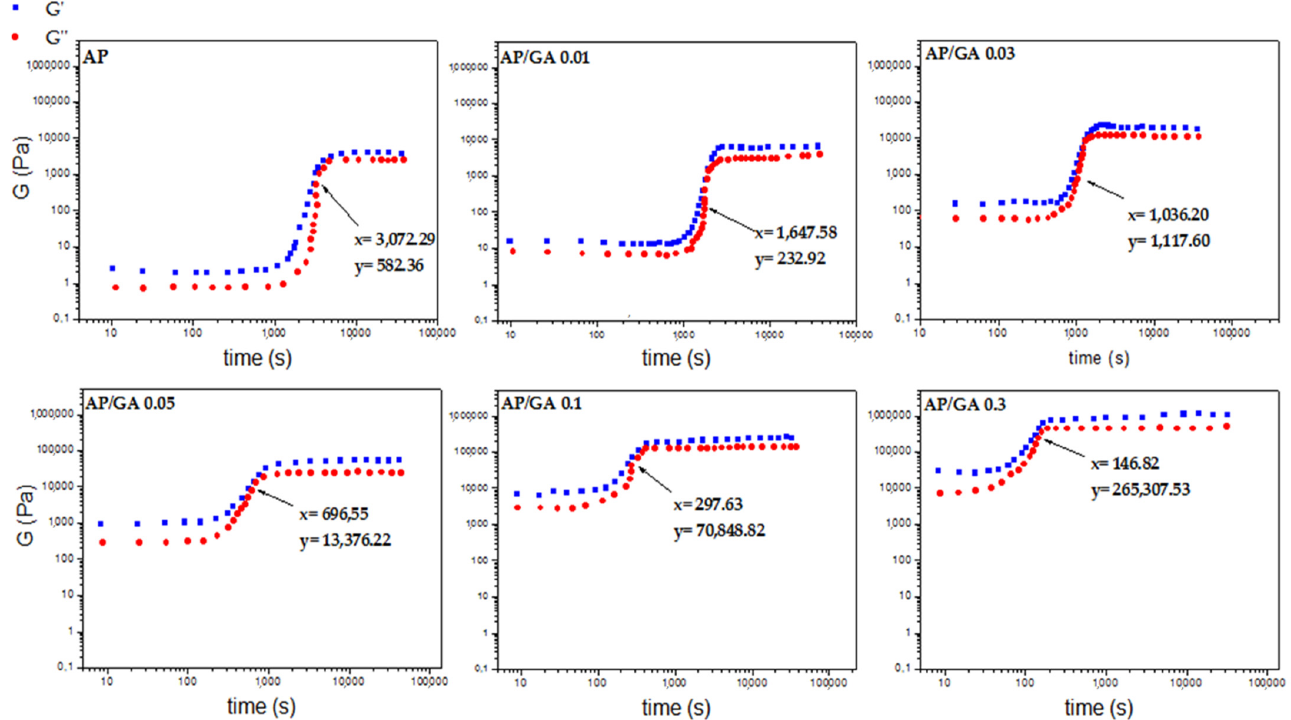
Figure 6. Cross-point between elastic and loss modulus (G’ and G”) vs. time of AP and AP/GA samples.